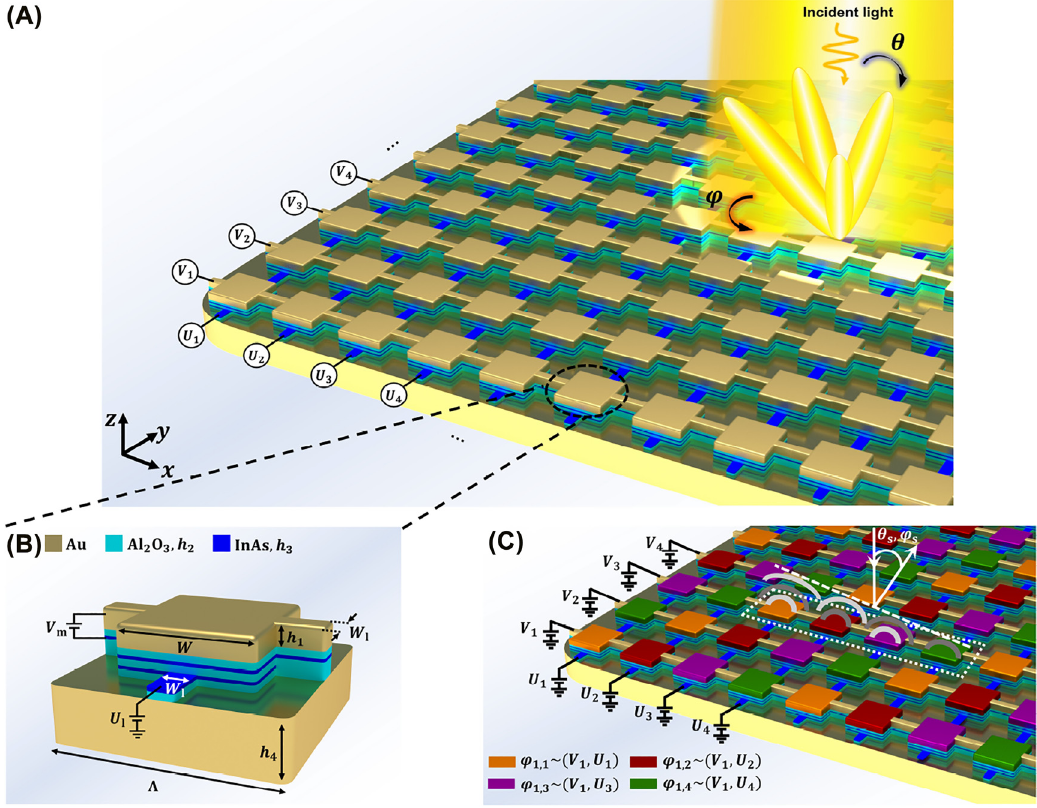
Figure 1: Perimeter-controlled metasurface for two-dimensional dynamic beam steering. (A) Pictorial illustration of the perimeter-controlled plasmonic reflectarray under the normal illumination of the incident wave for two-dimensional beam steering. (B) The configuration of the = 23 nm, W = 650 nm, and electrode W = 150 nm), alumina plasmonic unit cell. Constitutive layers from top to bottom: Au square patch ( h 1 l = 15 nm), InAs active layer ( h = 10 nm), alumina dielectric layer ( h = 15 nm), InAs active layer ( h = 10 nm), alumina dielectric spacer ( h 2 3 2 3 = 15 nm), and Au back reflector ( h = 200 nm). The Au electrodes connect the patch nanoantennas in the same row along dielectric layer ( h 2 4 x direction and the InAs electrodes connect the bottom InAs layers in the same column along the y direction. The biasing configuration allows for independent biasing of columns and rows by application of the external bias voltages of U and V , respectively. The reflectarray consists of 9 × 9 elements with the inter-element spacing of Λ = 1033 nm. (C) Conceptual illustration of the row–column addressable elements. The ,𝜑 colored patches represent the elements with different phase distribution required for beam steering toward the angles ( 𝜃 s s